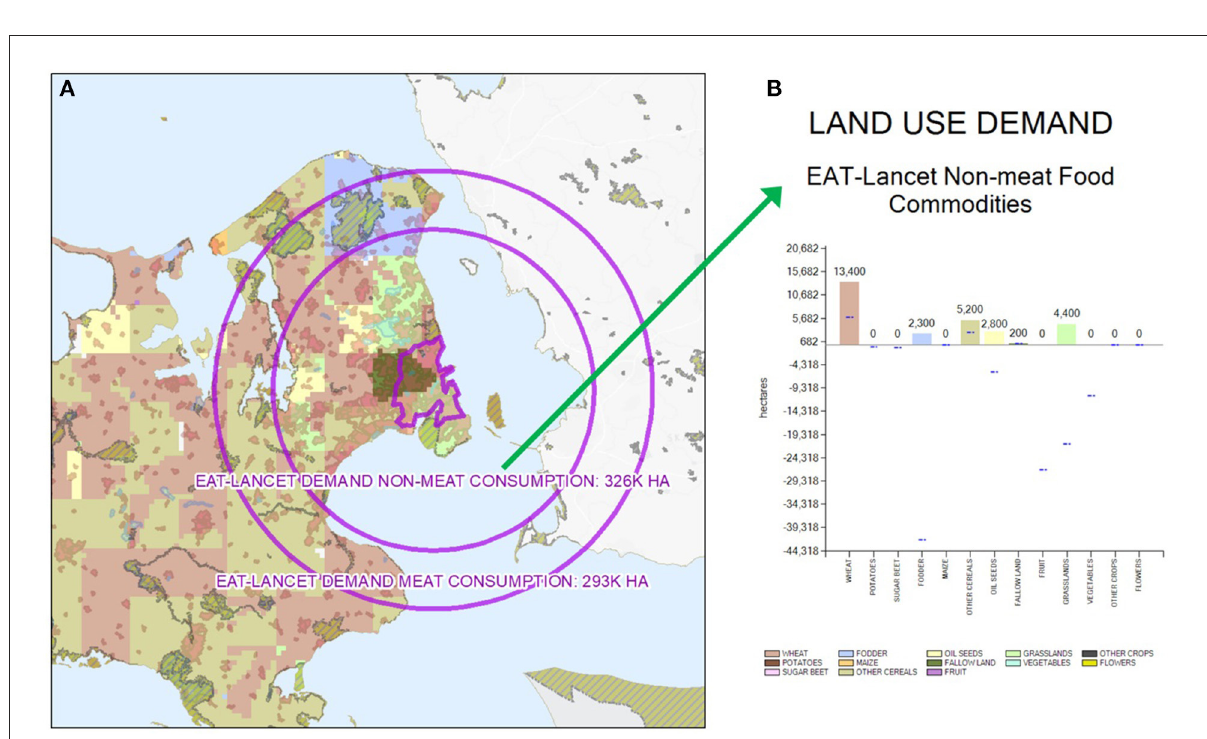
FIGURE6 Land footprint EAT-Lancet food consumption in Copenhagen: (A) overlaid with map of food groups. (B) Chart showing the aggregated food group supply values in hectares within each ring for this scenario.